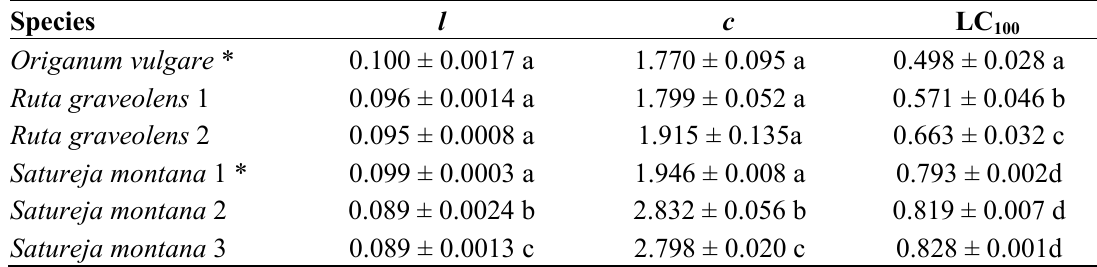
Table 2. Estimated values (mean ± SE) of highest concentrations of essential oil at which the mortality is strictly zero ( l ), symmetry of mortality distribution ( c ), and concentrations necessary to result in 100% Bursaphelenchus xylophilus mortality (LC